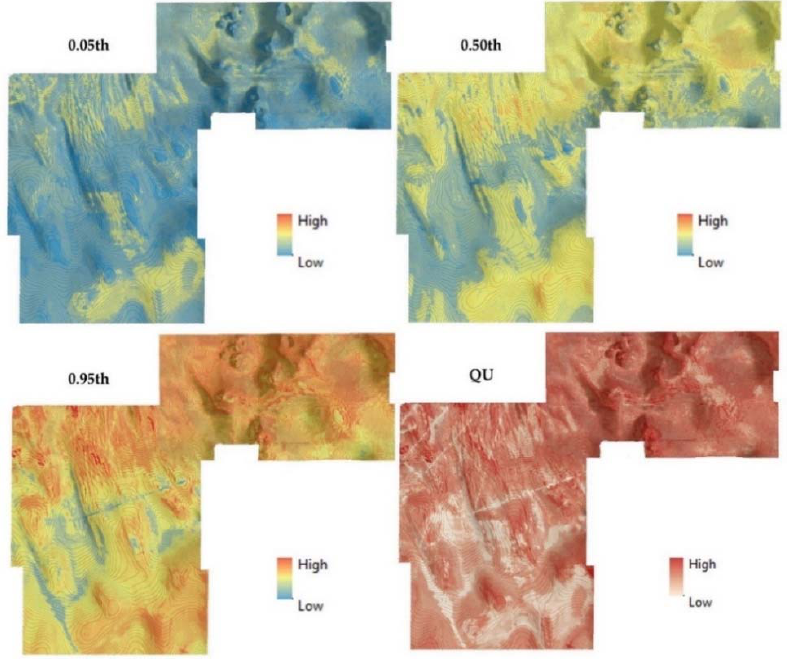
Figure 8. QRF spatial predictions for the entire AUV-mapped area. PMN are spatially aggregated in the northern and southern parts of the DEA, with the eastern part being the least covered. Despite the overall spatial agreement, the 0.05th and 0.50th quantiles predict the extent of the PMN free black patches better. In addition, the 0.95th quantile has linear artifacts; these are caused due to the difference between the model trend and sample values. The quantile uncertainty (QU) is minimized in the areas that have samples (here images) and have a similar seafloor geomorphology. The superimposed bathymetric contours have a 1 m depth